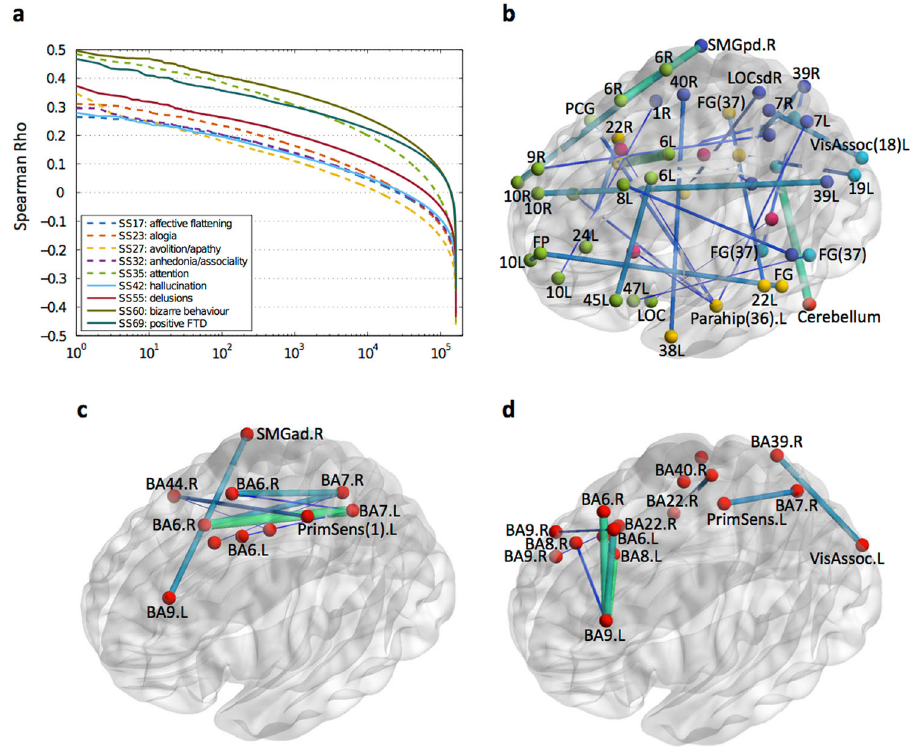
Fig. 5 a Correlations between all link-weight features and scales. SANS and SAPS scales are shown using dashed and solid lines , respectively; b – d stable across CV-folds subset of most-predictive links selected by EN for predicting the global rating of b attention, c severity of bizarre behavior and d positive formal thought disorder. Links thickness and color is scaled based on the average weight of links across CV-folds in the EN model. In b , nodes are color-coded based on the lobe they are located in, as follows: frontal ( green ), parietal ( dark blue ), temporal ( yellow ), occipital ( blue ); cerebellum ( red ) and white matter ( magenta ). (see also Supplementary Fig. S9 for a reference map of all BAs; for the scale SS35 [attention], the third best model was used for visualization, as the links map for the best model was very complex [129 out of